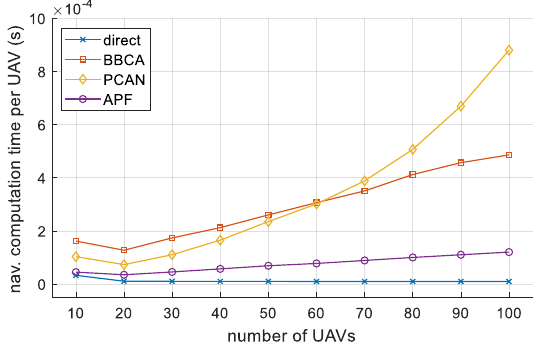
Figure 14. Time (per UAV) consumed by the navigation algorithm.